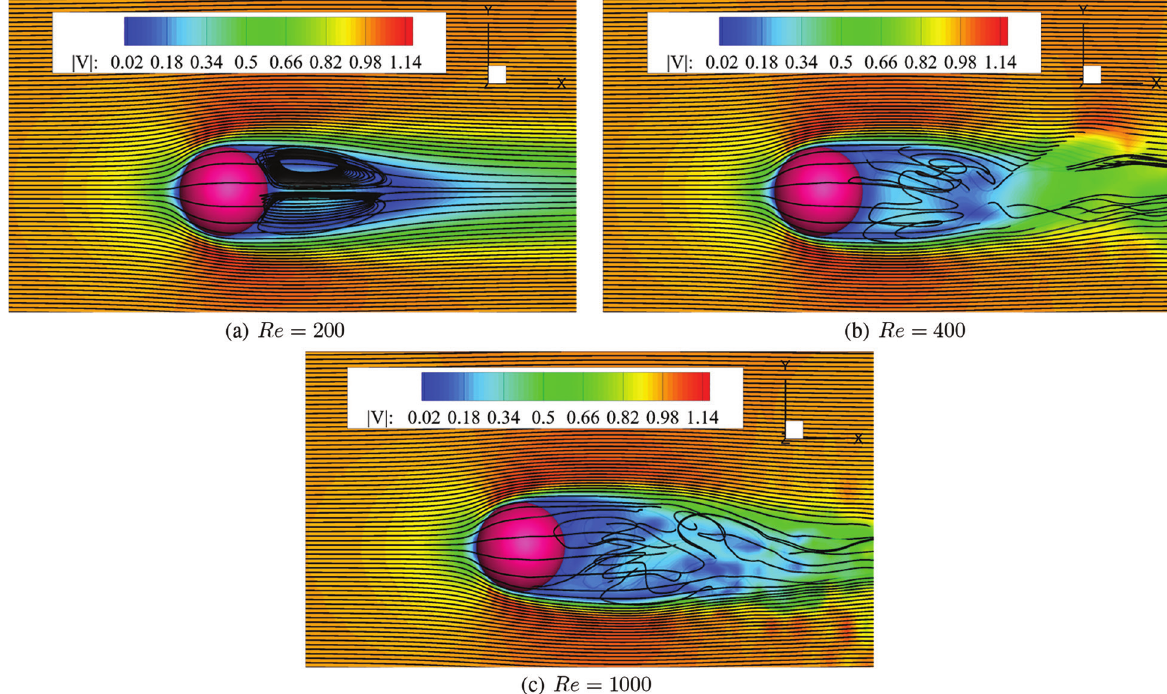
Figure 15 - Velocity field and streamlines for the flow over the sphere, for three values of the Reynolds numbers: (a) Re =200, (b) Re =400 and (c) Re =1000.